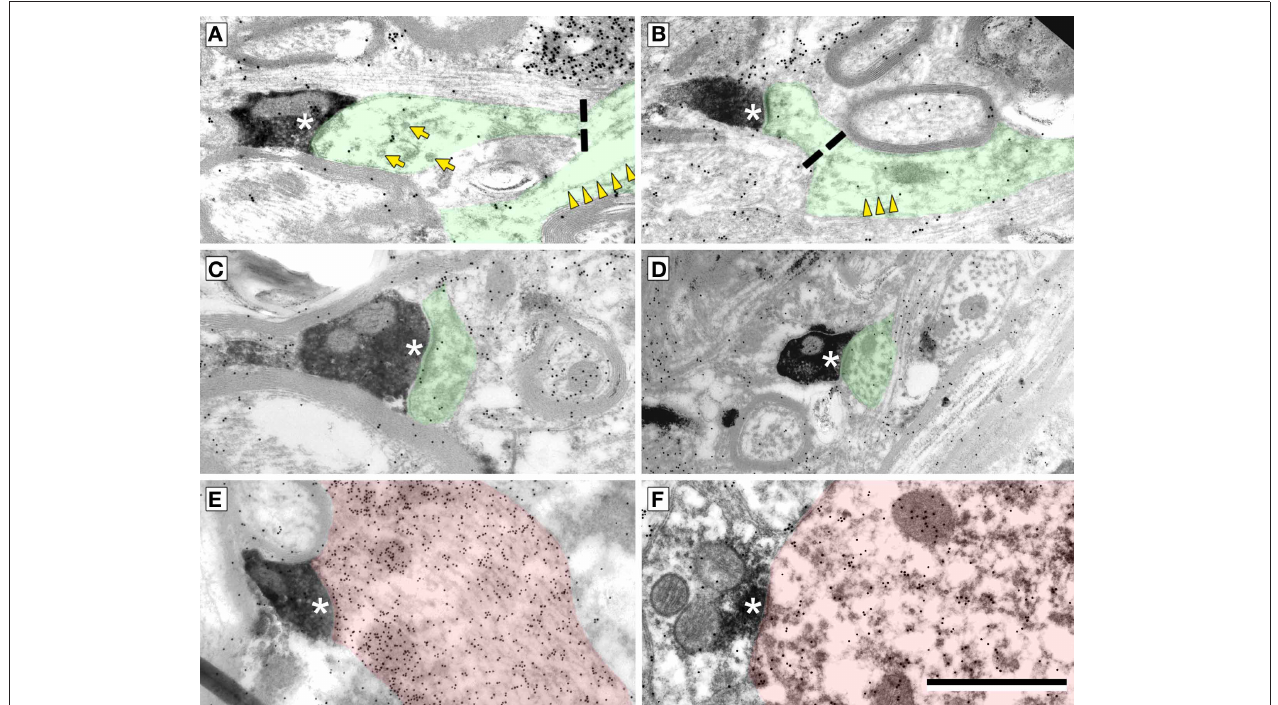
FIGURE 4 | Electron micrographs showing examples of electron dense cortical boutons forming synapses ( ∗ ) onto dendritic spines (A–C), dendritic shafts (D,E) or a soma (F). (A,B) Synapses onto GABA-negative dendritic spines with parent dendrites visible. Dashed line indicates the junction of the spine neck and dendritic shaft. Microtubules (yellow arrowheads) are present in dendrites, but not in